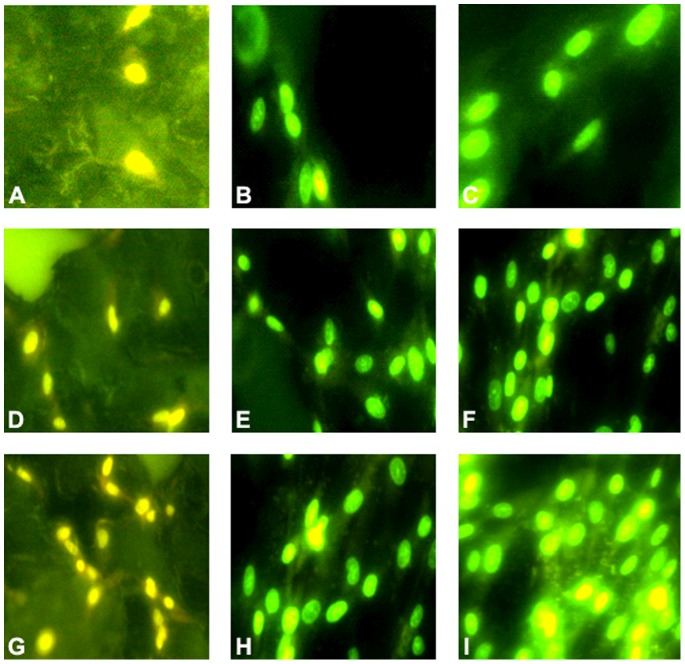
Detection of cell adhesion and proliferation after the cells were mixed with the alloy specimens.(A–I) The figures respectively showed cells proliferating in the compact group at the time point of 3 h, 24 h and 72 h. The cells all attached and proliferated well (magnification ×200). (D–F) They presented the condition of cells proliferating in the 40% porosity group at the time point of 3 h, 24 h and 72 h. The cells proliferating speed is faster than the compact group (magnification ×200). (G–I) The cells proliferating speed is fastest among the three groups, however, cells interconnected confluently in the 70% porosity group at the time point of 72 hours (magnification ×200).